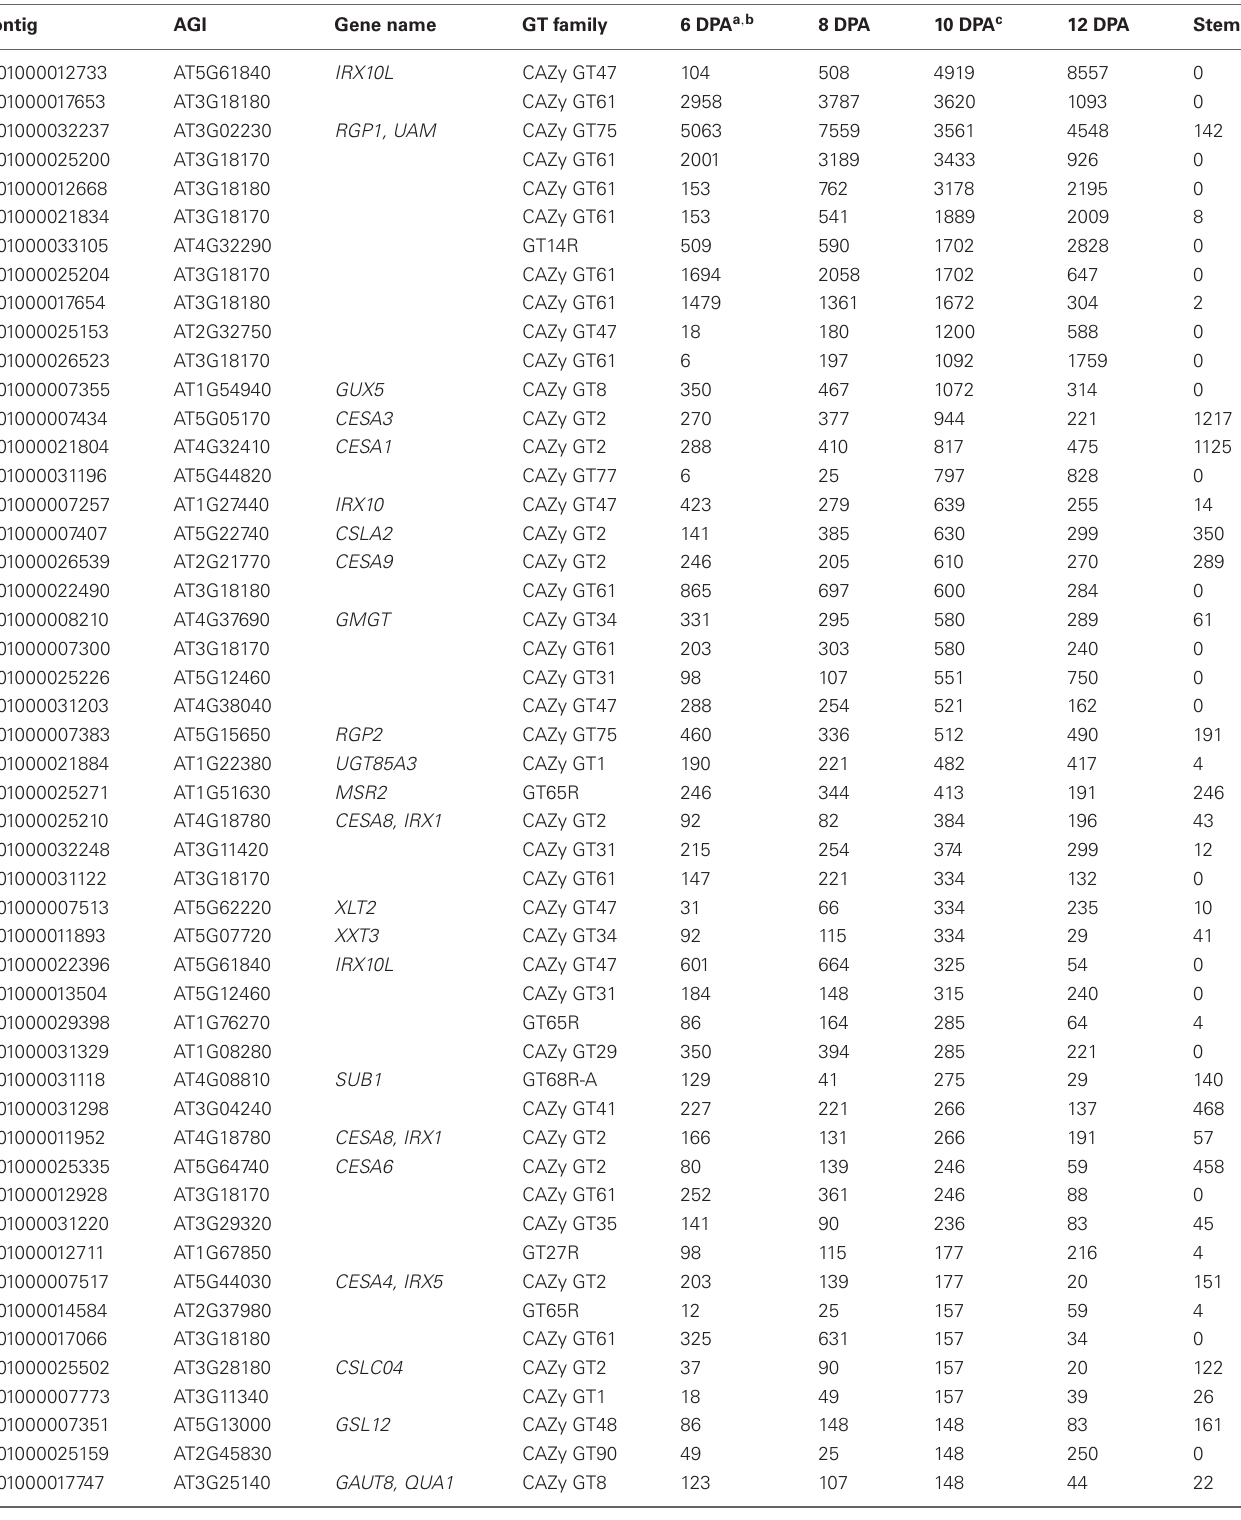
Table 1 | The 50 most abundant transcripts expressed in psyllium mucilaginous layers encoding putative